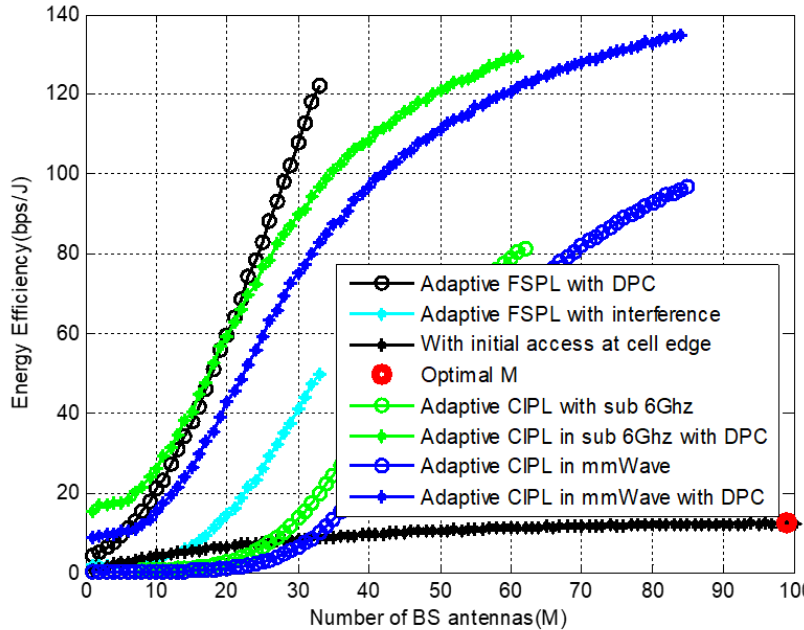
Figure 8. Energy efficiency evaluation as a function of the number of BS antennas with at mmWave frequency, f = 38 GHz and sub-6 GHz, and f = 2.5 GHz.